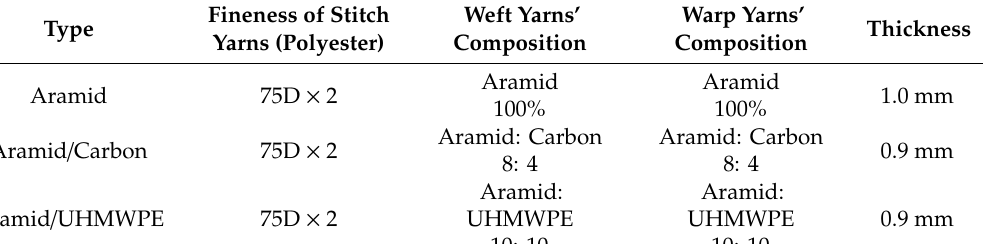
Table 2. Parameters of three types MBWK fabrics. Table 1. Specification of inserting yarns.